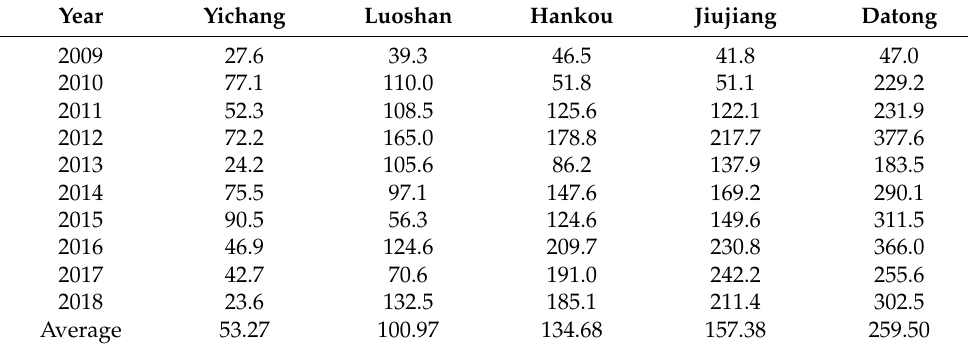
Figure 10. Comparison of the maximum 30-day runoff during flood season between the five gauging stations. If points are above the 1:1 line, the reconstructed runoff is greater than the observed runoff, and the TGD has reduced the maximum 30-day runoff. In contrast, if points are below the 1:1 line, the reconstructed runoff is less than the observed runoff, and the TGD has increased the maximum 30-day runoff. Table 5. The difference between the observed maximum 30-day runoff and the reconstructed maxi- mum 30-day runoff after the full operation of the TGD from 2009 to 2018. If the difference is greater than 0, the TGD has reduced the maximum 30-day runoff during flood season. Difference = R Re − R Ob ; R Re : reconstructed maximum 30-day runoff; R Ob : observed maximum 30-day